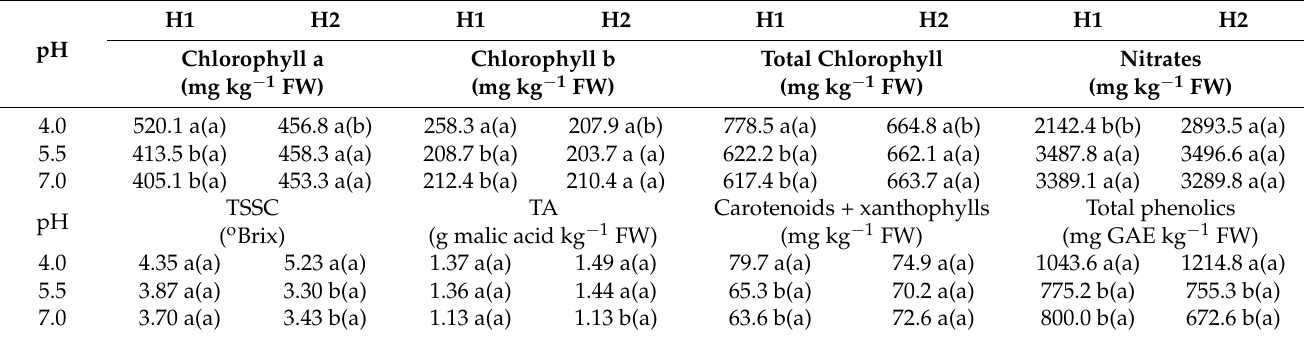
Table 8. Total soluble solids content (TSSC), titratable acidity (TA), carotenoids + xanthophyls, total phenolics, chlorophylls (a, b and total) and nitrate content of Reichardia picroides leaves grown under different nutrient solution pH, harvested at H1 (22-DAST) and H2 (41-DAST: Days after the Start of pH